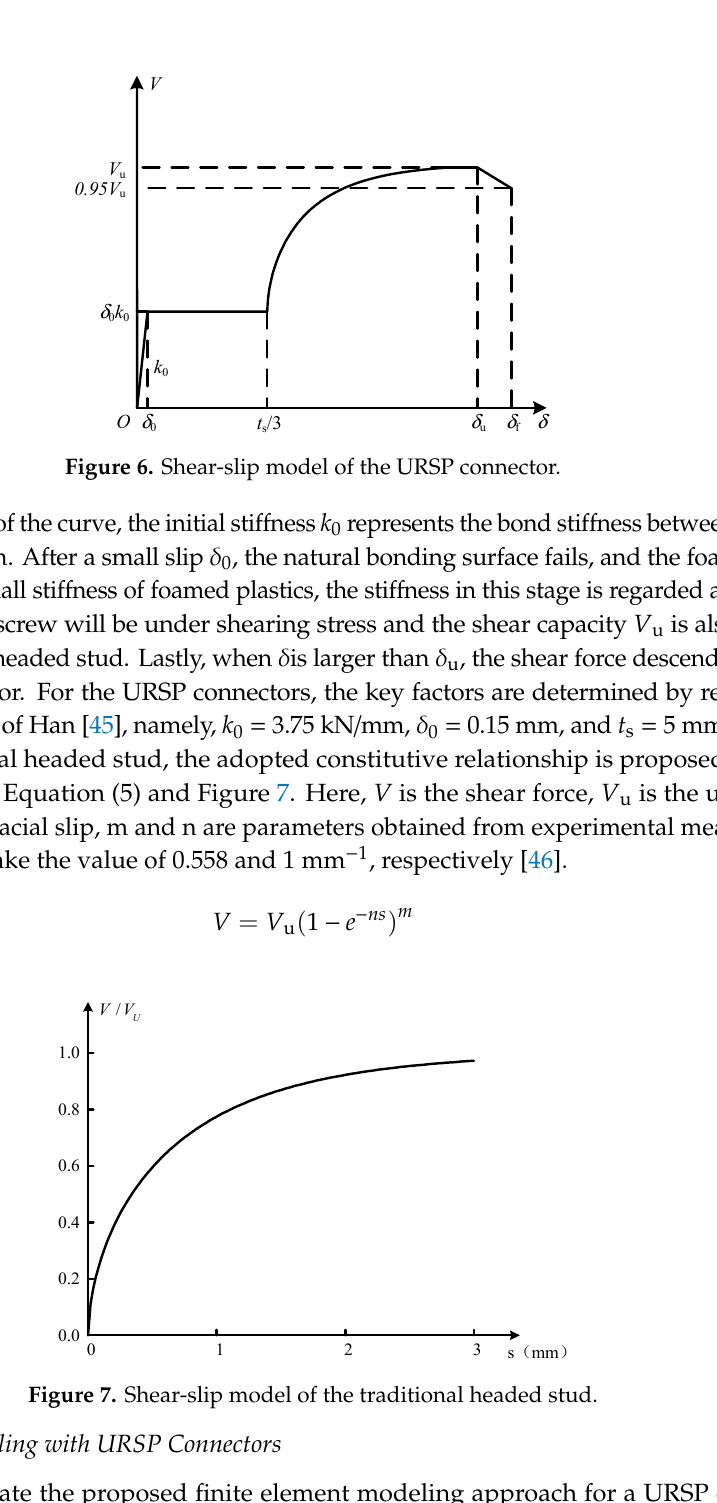
Slab centroidal axis Figure 5. Simulation of the shear connector in the finite element model. For the shear connector, based on the theoretical analysis of the tensile stiffness of headed stud connectors in reference [43], a very large stiffness value is adopted for the definition of the spring in the vertical direction to simulate the uplift restraint, which is similar to the rigid link as reported in references [18,44]. The shear force-slip relationship curve for URSP connectors illustrated in Figure 6